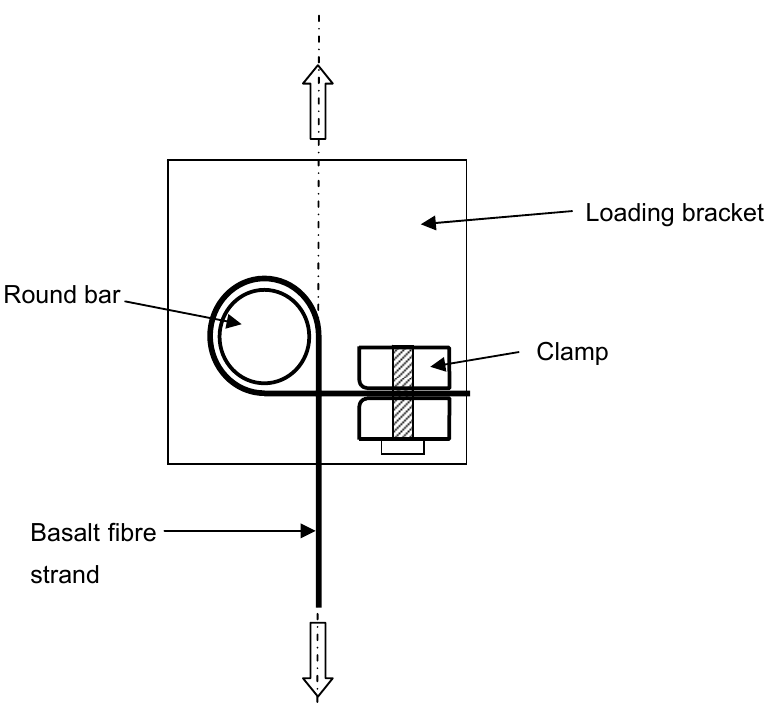
Figure 6. Fibre clamping